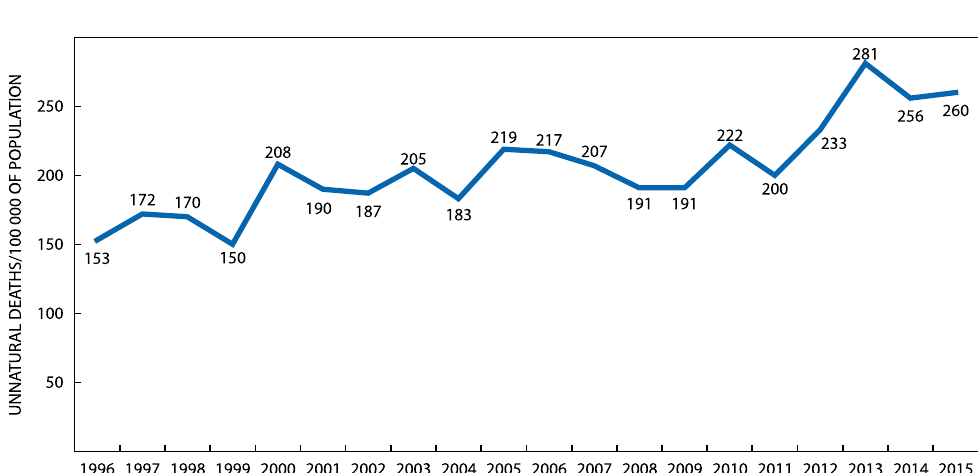
Figure 1: Unnatural death rate per 100 000 of population in the Transkei region of South Africa ( n = 24